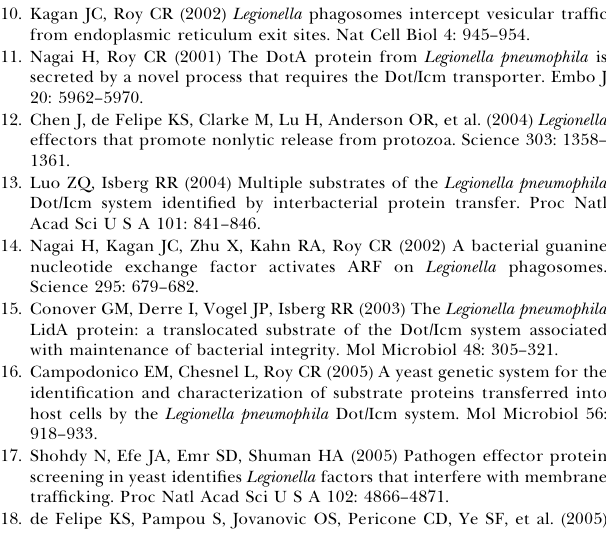
Table S1. Bacterial Strains, Plasmids, and Primers Employed in This